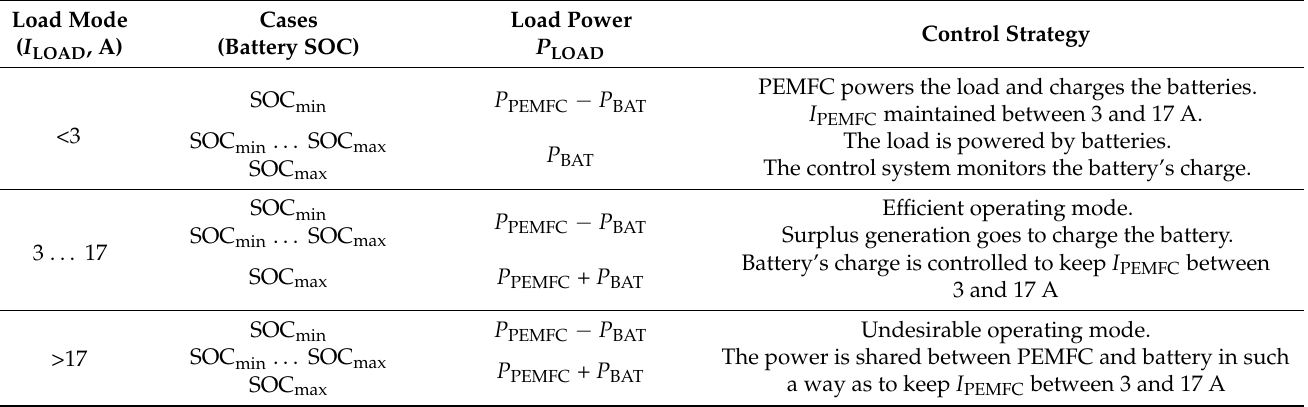
Table 2. Power distribution strategy between the fuel cell and the battery in